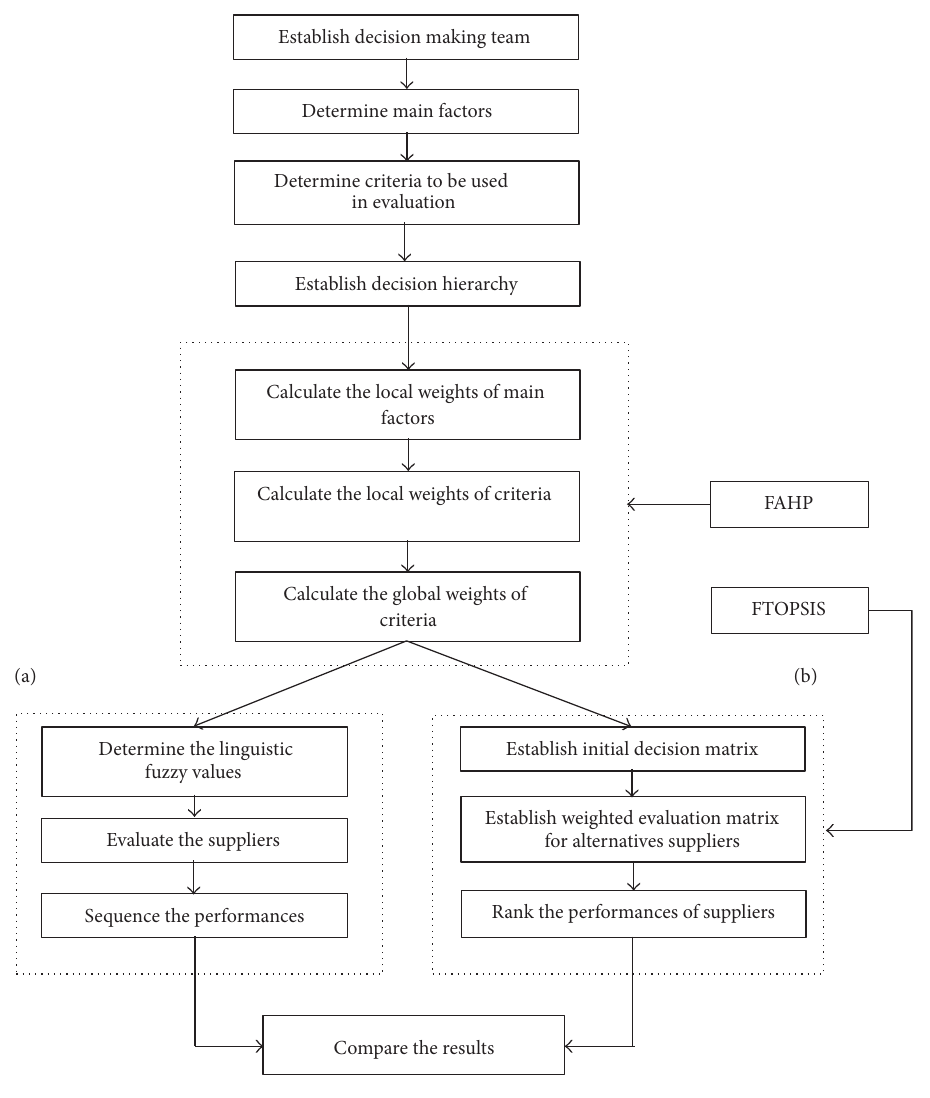
Figure 1: Schematic diagram of the proposed algorithms.